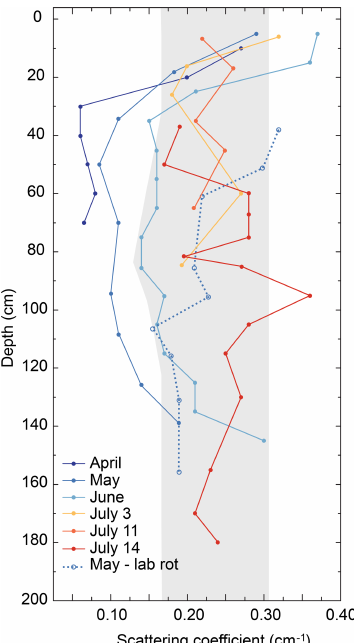
Figure 11. Vertically resolved scattering coefficients of sea ice mea- sured during each phase of the field campaign. Coefficients are in- ferred from laboratory optical transmittance measurements (after Light et al., 2015) and interpretation of a radiative transport model in cylindrical domain (Light et al., 2003b). The April profile is in- cluded to show spring ice was measured on ice sampled in 2012 at a comparable geographic location. The May lab rot profile is for ice extracted in May during a field campaign and then warmed in the lab prior to subsample preparation. The shaded area shows the range of measurements on melting multiyear ice (Light et al., 2008) and melting first-year ice (Light et al.,